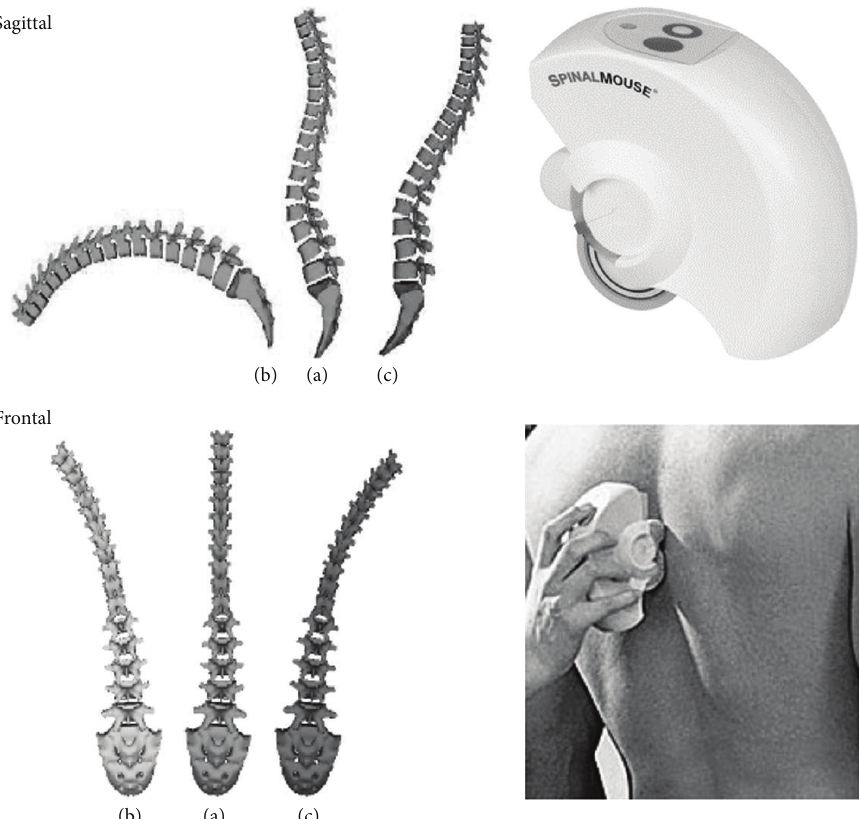
Figure 1: Spinal Mouse is a device which is guided manually on the skin along the spine. Reconstruction of the spine in neutral and extreme positions in sagittal and frontal plane. The images are derived from real measurements in one patient. Sagittal plane: (a) upright position, (b) full flexion, and (c) full extension. Frontal level: (a) upright position, (b) left lateral bending, and (c) right lateral